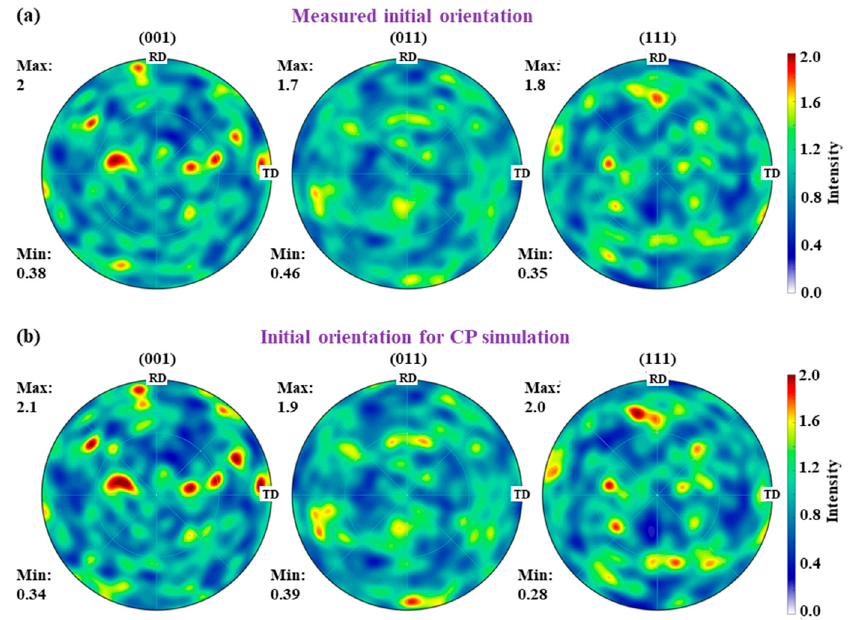
Figure 7. Pole figure characterizing ( a ) the measured initial orientation and ( b ) the initial orientation for CP simulation. Table 4. Definitive constitutive parameters for the phenomenological CP model. Variable